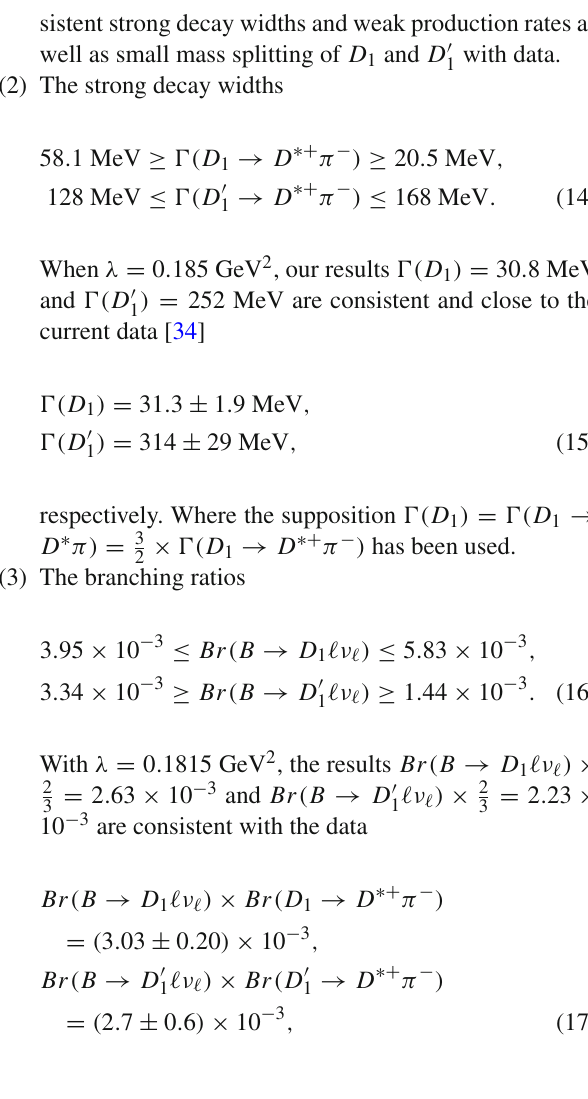
( 2430 ) (green line). Between the blue and orange dotted lines is the range of our best 1